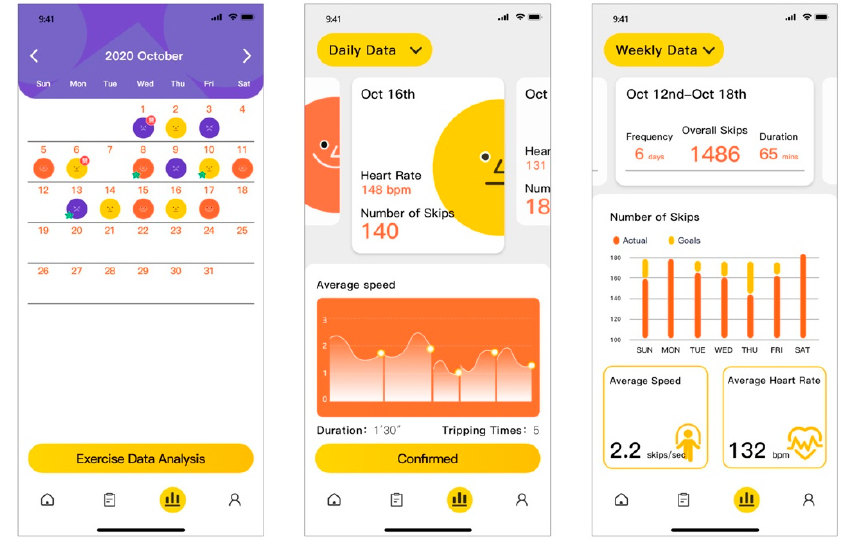
Figure 12. Exercise data analysis.